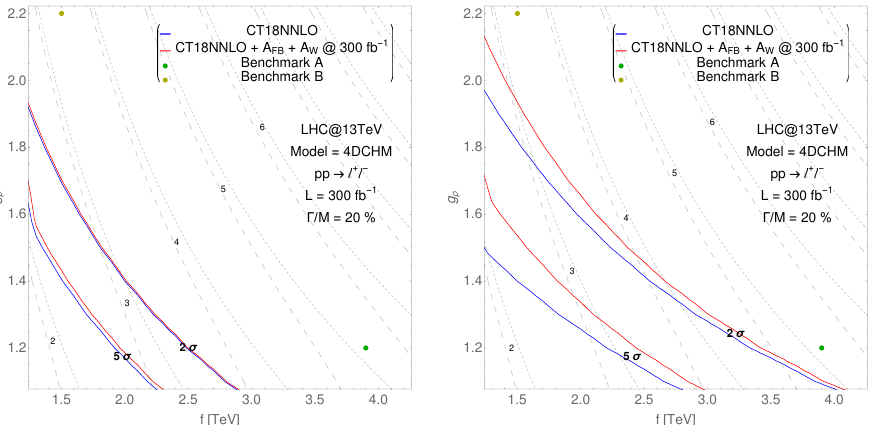
Figure 2 . Exclusion and discovery limits at 300 fb − 1 for the peak (left) and for the dip (right) for Z 0 resonances with Γ Z 0 /M Z 0 = 20% . The short (long) dashed contours give the boson mass M Z ( M Z ’ M W ) in 3 2